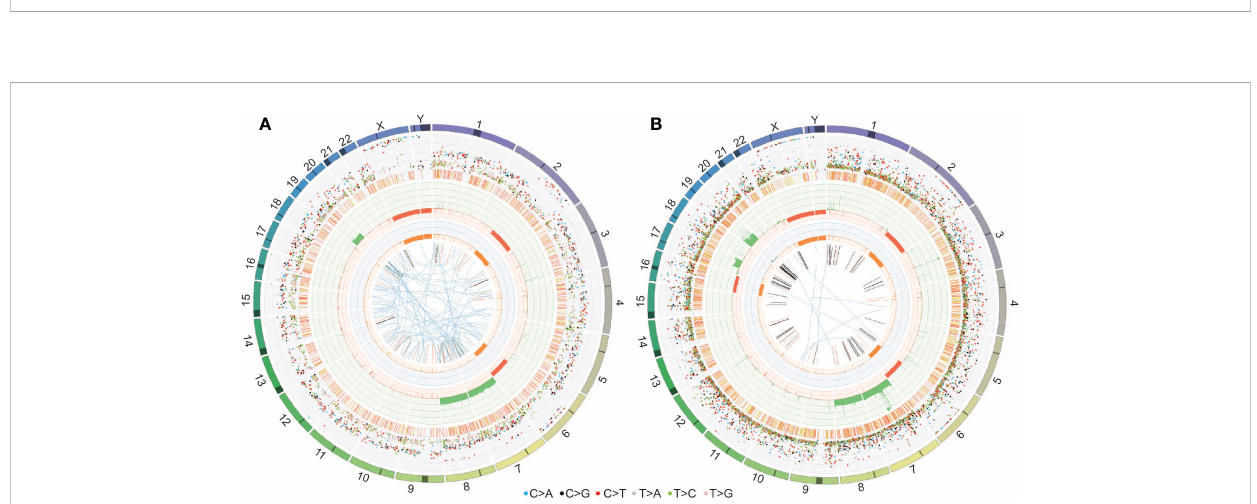
FIGURE 7 CIRCOS plots for (A) the fourth surgical sample and (B) the PDOX TK-EPN862 tumor con fi rm the chromosomal gains and losses observed in the copy number plots. Key to the CIRCOS plots: Outermost circle indicates the chromosomes, where darker shading represents large gaps in the human reference genome (e.g., centromeres). Second circle ( grey shading ) shows the somatic variants. These are divided into an outer ring of single nucleotide variants where each dot represents a single variant colored as shown with allele frequencies (corrected for tumor purity and scaled from 0-100%) and an inner ring of short insertions and deletions ( yellow and red , respectively). Third circle ( red and green shading ) shows all observed tumor purity-adjusted copy number changes (losses and gains indicated in red or green , respectively; scale ranges from 0 (complete loss) to 6 (high level gains)). Fourth circle ( orange and blue shading ) represents the observed ‘ minor allele copy numbers ’ across the chromosome, ranging from 0 to 3. The expected normal minor allele copy number is 1. Values below 1 are shown as a loss ( orange ) and represents a loss of heterozygosity event, whilst values above 1 ( blue ) indicate ampli fi cation events of both alleles at the indicated locations. Innermost circle displays the observed structural variants within or between the chromosomes. Translocations are indicated in blue, deletions in red, insertions in yellow, tandem duplications in green and inversions in black.